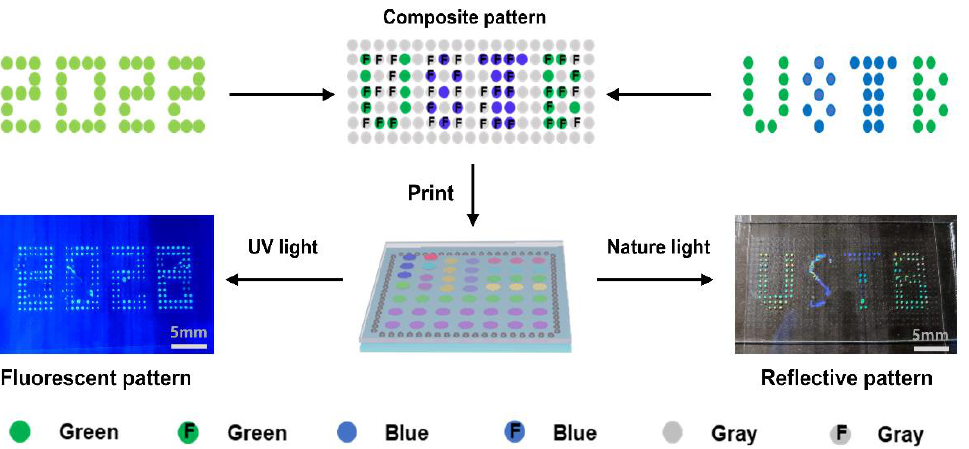
Figure 6. Schematic of the preparation of LC microdroplet arrays with two different messages. The LC microdroplet arrays showed a colored “USTB” pattern under natural light and a green “2022” pattern under UV irradiation. The blue, green, and gray colors of the blocks represent the reflection colors of the microdroplets, and the letter “F” represents the microdroplets with fluorescence.